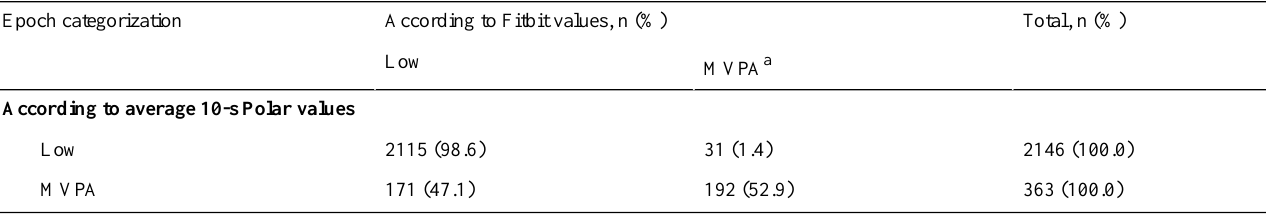
Table 3. Number of 1-min epochs spent in Centers for Disease Control and Prevention (CDC) physical activity heart rate zone; n=2509 paired observations. Sensitivity and specificity were 52.9% (192/363) and 98.6% (2115/2146), respectively. The positive predictive value for a 1-min epoch categorized as MVPA by Fitbit values was 86.1% (192/223), and the negative predictive value was 92.52% (2115/2286).